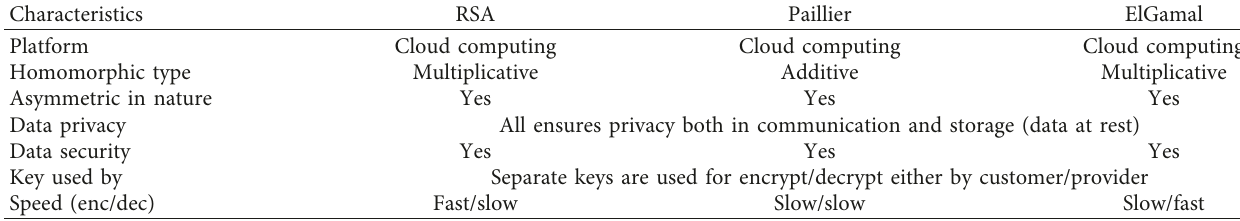
Table 2: Homomorphic encryption